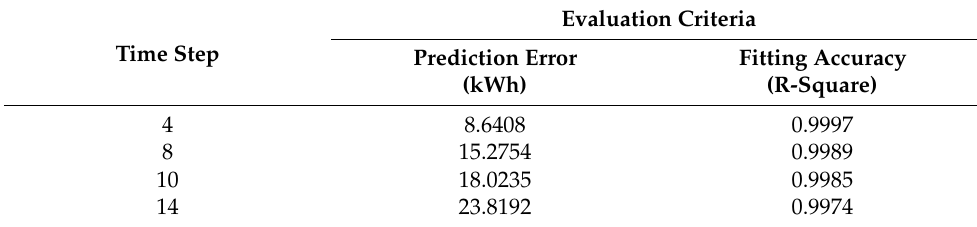
Table 8. Comparison of multi-step prediction results.